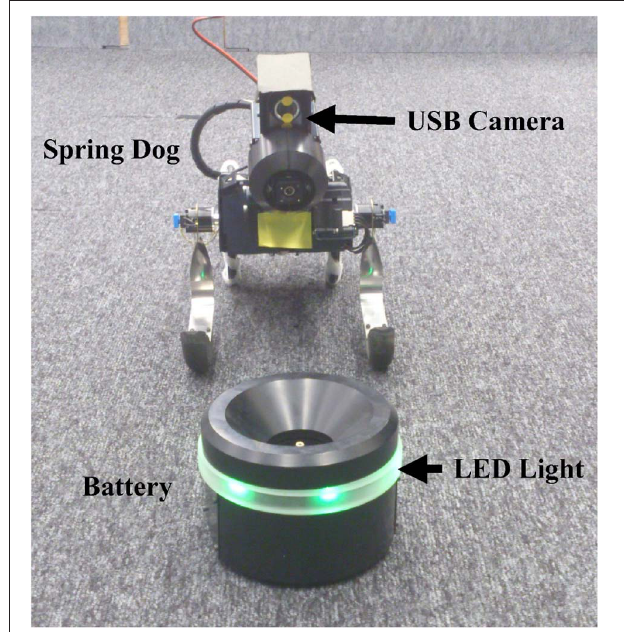
FIGURE 2 | Spring Dog, wheel typed robot and the battery pack.